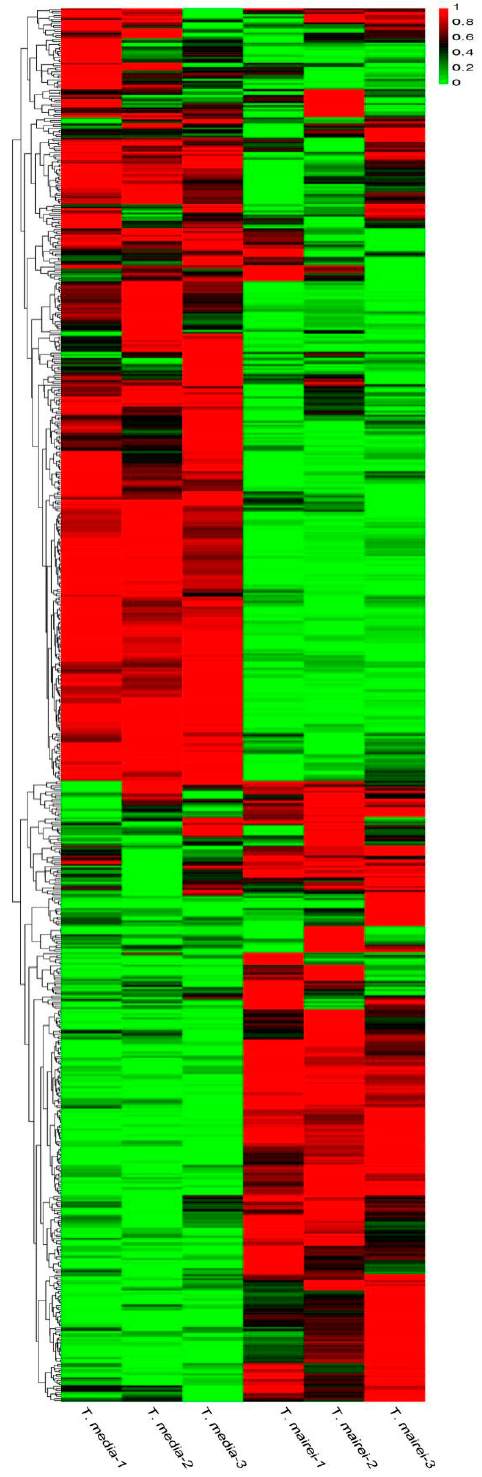
Figure 2. A heatmap of the metabolites identified in the metabolomes of the two Taxus species ( n = 3). The content of each metabolite is represented by a color bar. With the increase in the metabolite content, the color of the bar changed from green to